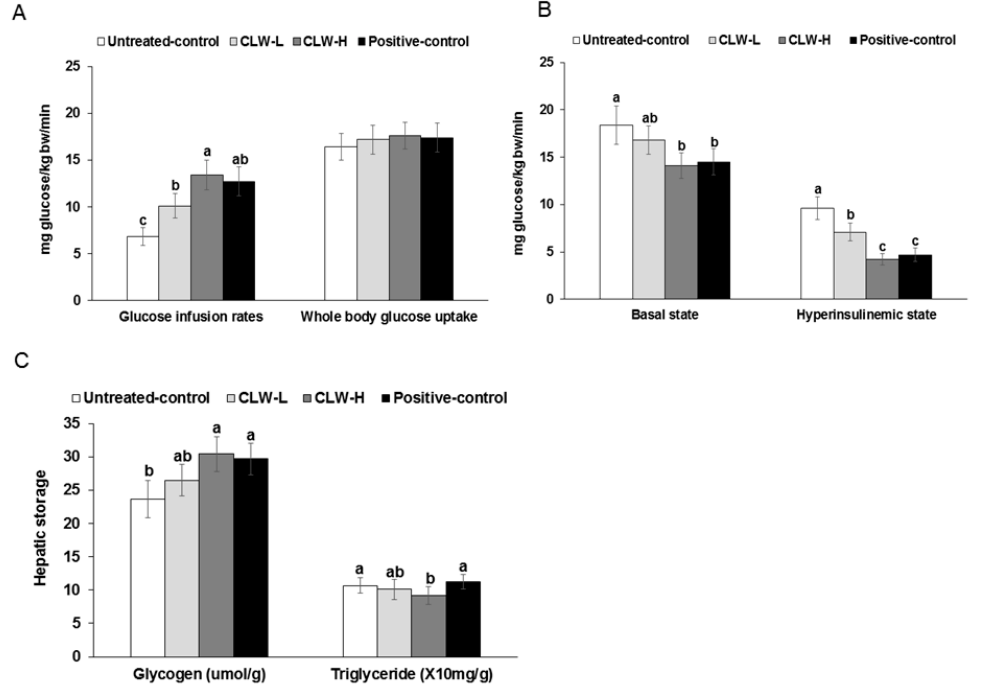
Figure 4. Metabolic parameters during euglycemic hyperinsulinemic clamp. Px rats fed a high-fat diet supplemented with 0.3% lyophilized water extract of C. lanceolata + 0.7% cellulose (CLW-L), 1% lyophilized water extract of C. lanceolata (CLW-H), 1% cellulose (untreated control), or rosiglitazone (20 mg/kg body weight/day) + 1% cellulose (positive control) for 8 weeks. At the end of the